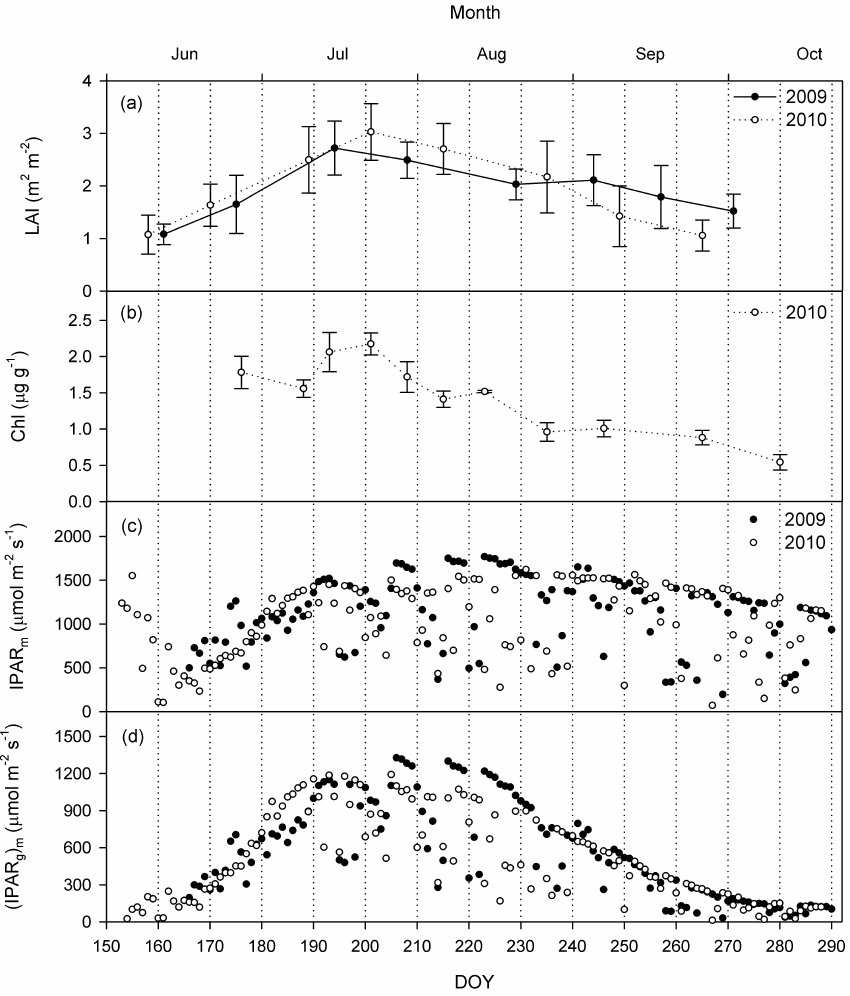
Fig. 3. Seasonal variation of 2009 (filled circles, solid line) and 2010 (open circles, dotted line): (a) leaf area index (LAI, m 2 m − 2 , mean ± SD, n = 12); (b) leaf chlorophyll concentration (Chl, µgg − 1 , mean ± SD, n = 12); (c) midday IPAR (IPAR m , µmolm − 2 s − 1 ); and